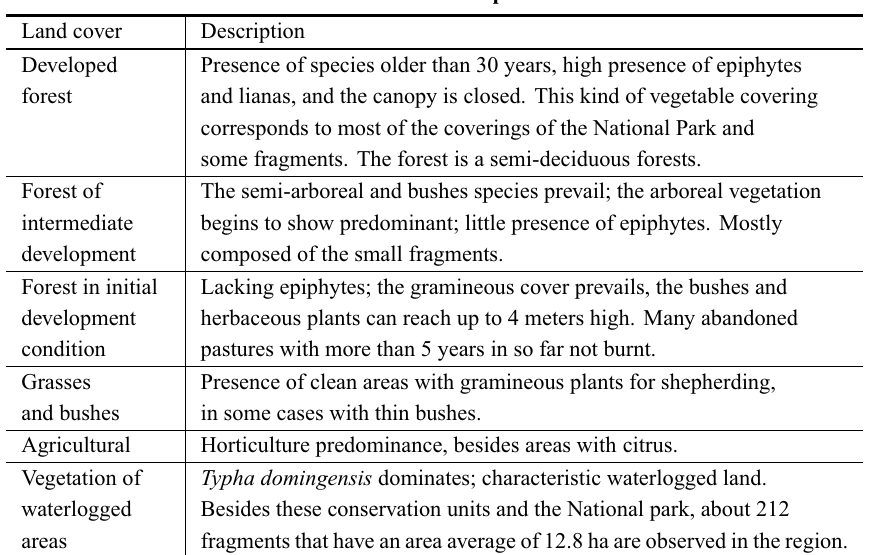
Land cover description.